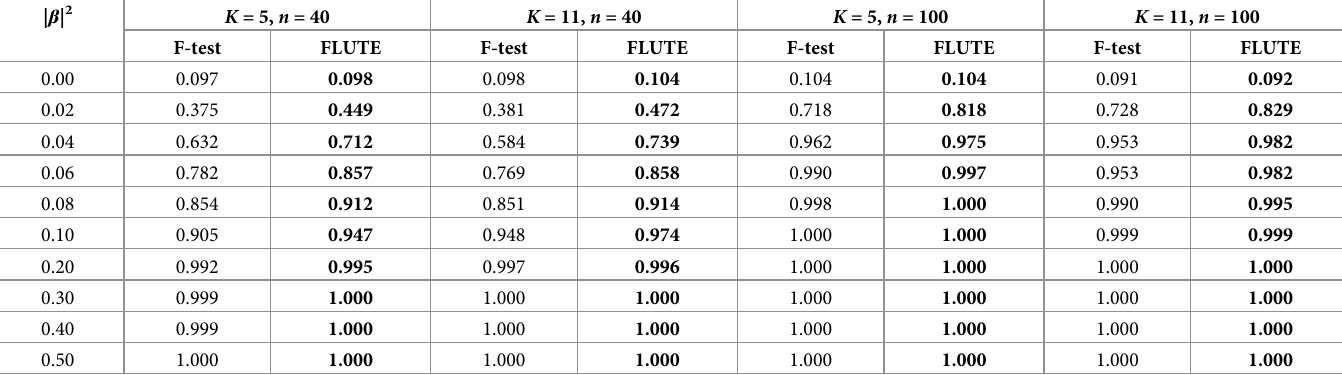
Table 7. Size and power for normal residual at significant level α = 0.1.